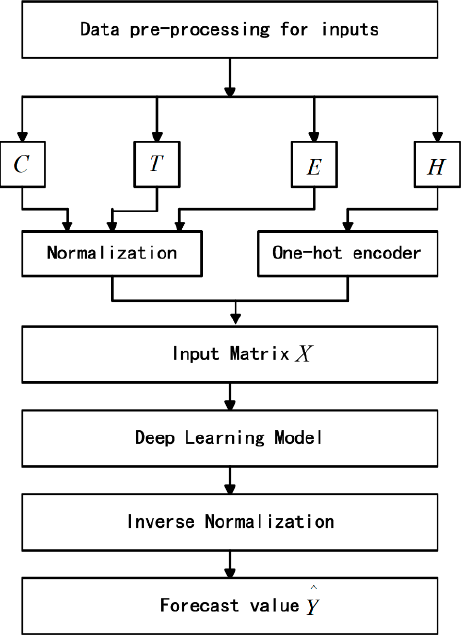
Figure 4. Deep learning model based forecasting framework.